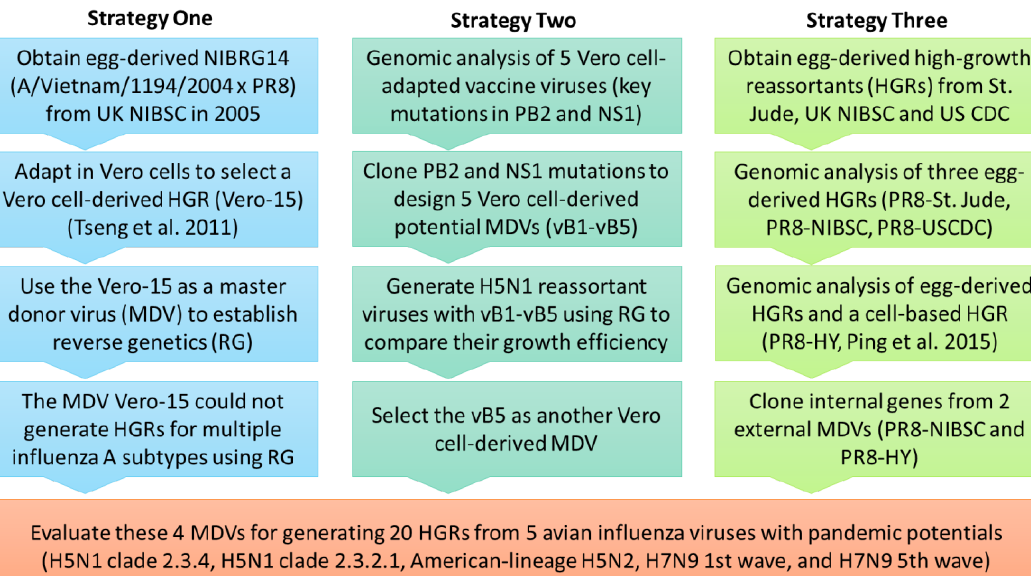
Figure 1. The study flowchart.